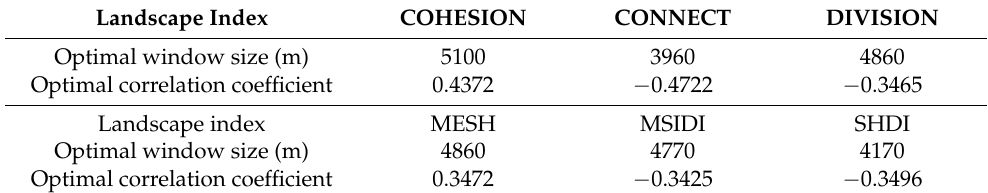
Table 7. Optimal window size of correlation coefficient exponential landscape index. Landscape Index